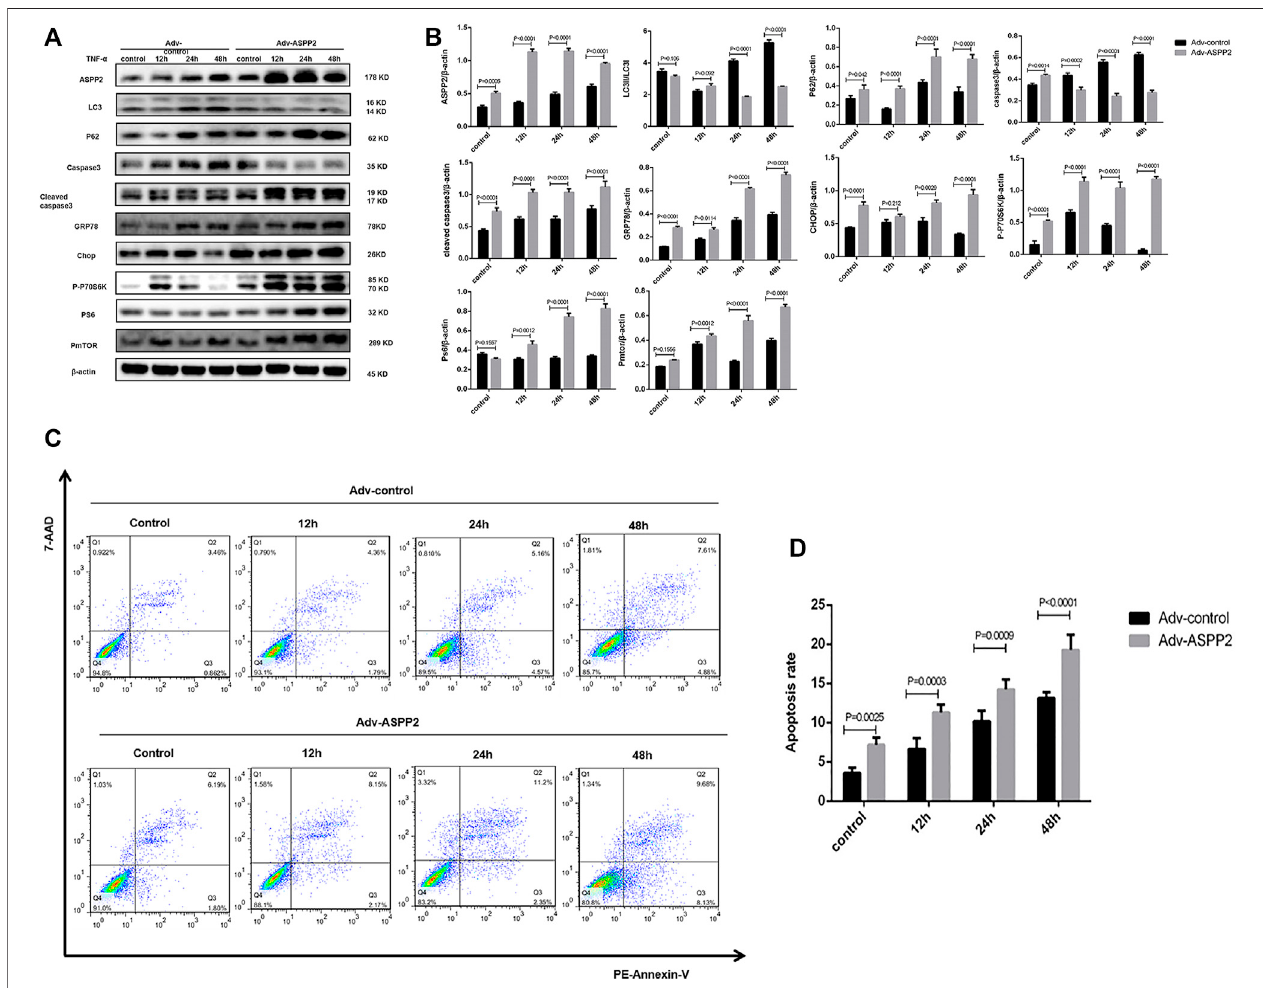
FIGURE 2 | ASPP2 upregulated mTORC1 and inhibited autophagy, but promoted apoptosis in case of hepatocyte injury induce by TNF- α . HL7702 cells were transfected by Adv-ASPP2 or Adv-control and then induced by TNF- α (25 ng/ml) for 12, 24, and 48 h, respectively. (A,B) Representative western blotting analysis was conducted of protein expression in HL7702 cells after treatment. Quanti fi cations were normalized to β -actin and expressed as relative density. (C,D) Representative apoptosis images were presented with PE and 7-AAD reagents by fl ow cytometry. The apoptosis rate was calculated using the proportion of early and late apoptotic cells in total